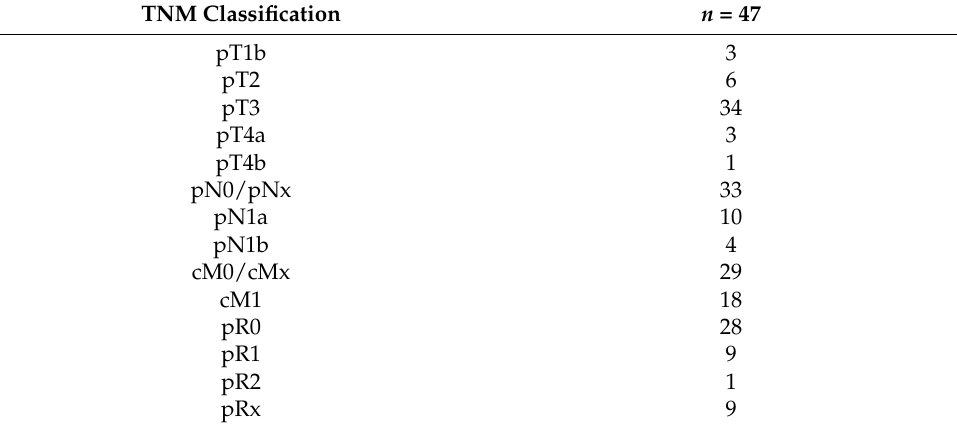
Table 2. TNM classification (7th edition of the American Joint Committee on